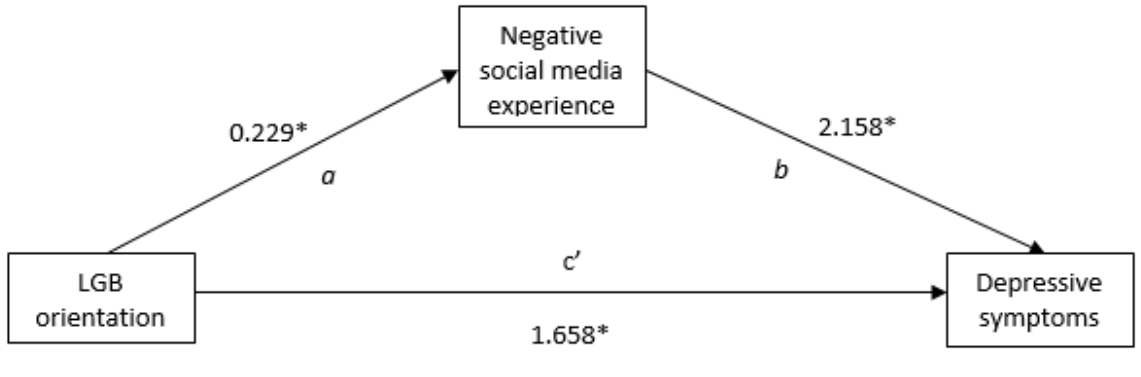
Figure 1. Path model (ab-c’) presenting observed coefficients of the conditional effect of LGB orientation on depressive symptoms via negative social media experiences. LGB: lesbian, gay, and bisexual. * P